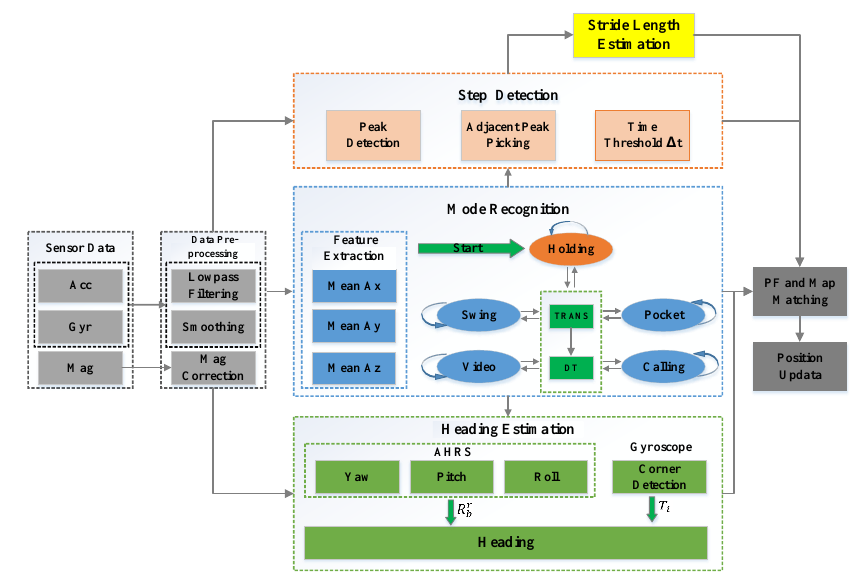
Figure 1. Architecture of the system.